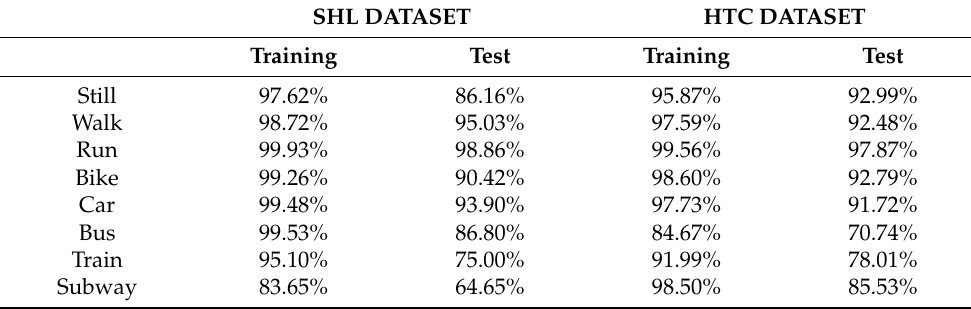
Table 5. Accuracy performances for training datasets and test datasets.